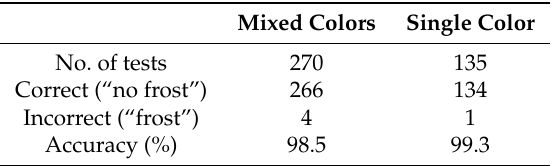
Table 6. False-positive test results under the no-frost condition and under good lighting with the trained CNN on the test